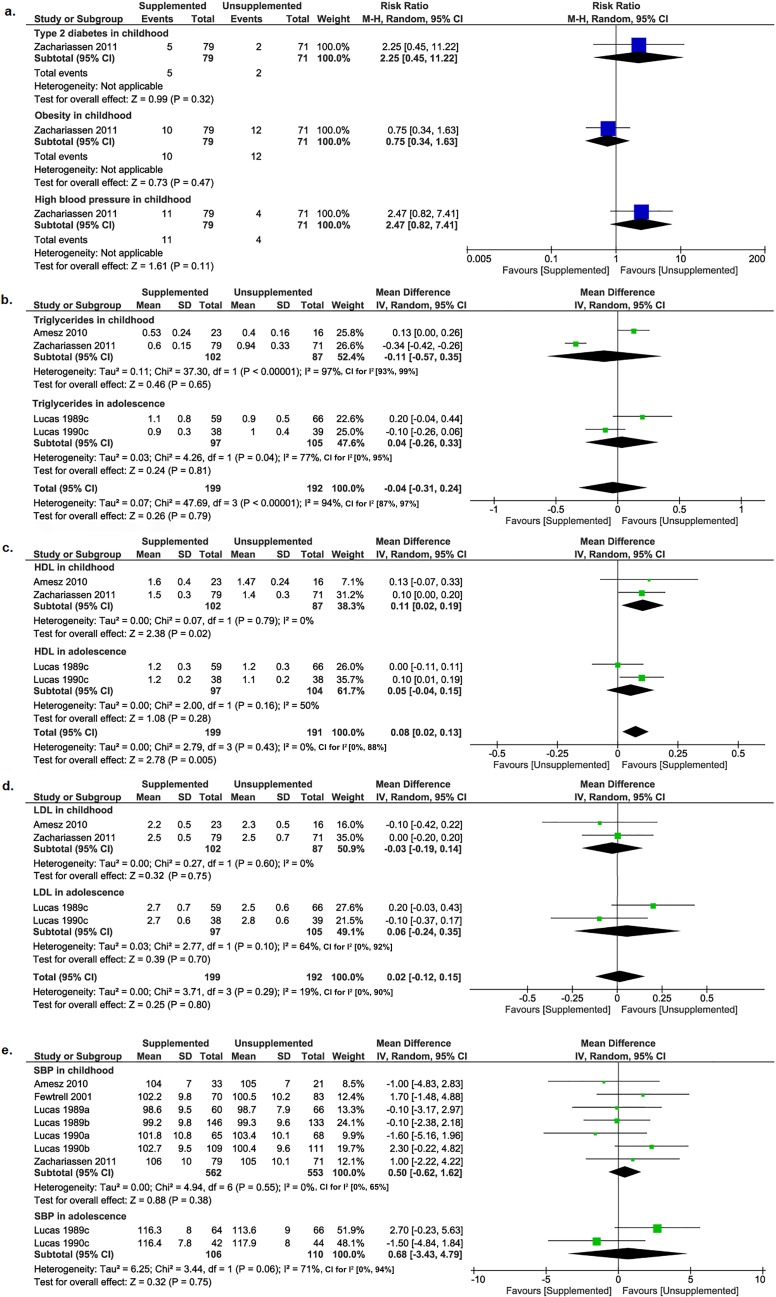
Forest plots of the effect of macronutrient supplements on secondary metabolic outcomes.(a) metabolic risks, (b) triglyceride concentrations, (c) HDL concentrations, (d) LDL concentrations, (e) SBP. Blue boxes in the forest plots represent the dichotomous data; green boxes represent the continuous data. CI, confidence interval; HDL, high-density lipoprotein; IV, inverse variance; LDL, low-density lipoprotein; M-H, Mantel-Haensel; SBP, systolic blood pressure; SD, standard deviation.